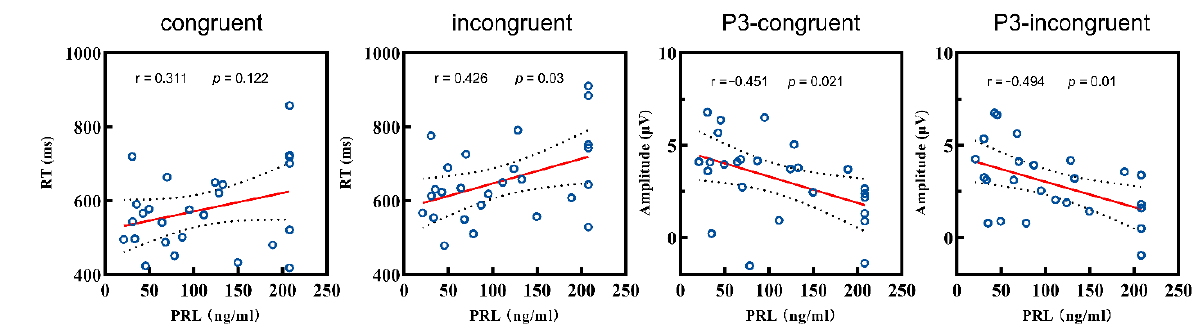
Figure 4. Correlations between the RT and P3 amplitudes and the PRL level of patient group. RT: reaction time; PRL: prolactin.